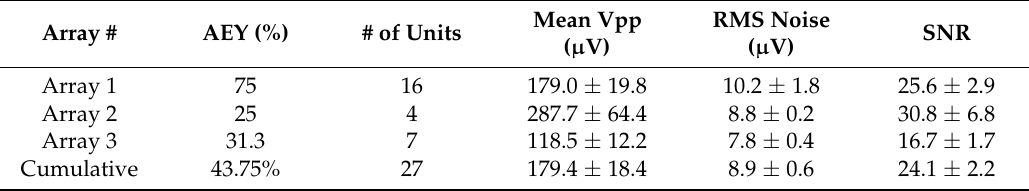
Figure 8. Acute extracellular action potentials recorded using 6 µ m a-SiC MEAs. ( a ) Filtered continuous data traces from three representative electrodes on Array 1. Vertical and horizontal scale bar represents 125 µ V and 1.75 s, respectively. ( b ) Left—Representative 2D principal component space indicating clear separation from the noise (central gray cluster). Right—Associated single units, indicating characteristic extracellular waveform shape. Vertical and horizontal scale bar represents 175 µ V and 0.6 ms, respectively. Table 1. Active electrode yield (AEY) percentage, total number of units, mean peak-to-peak amplitude, RMS noise, and SNR per array, and cumulative values across all arrays.